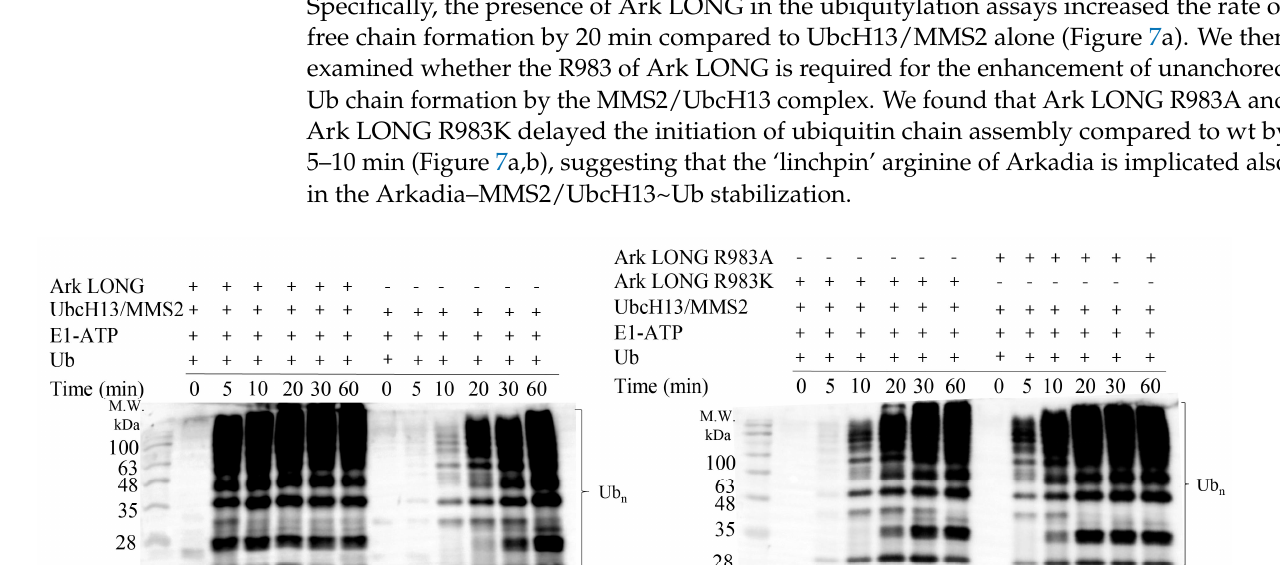
15 of 23 Figure 6. Interaction of E3 Arkadia with UbcH13 E2 enzyme. ( a ) Diagram of the total CSPs measured at a 1:2 molar ratio (saturation point) for 15 N Ark RING/ 14 N UbcH13, *: represents disappeared res- idues, +: represents residues with no information. ( b ) Ark RING mapping (PDBid: 2KIZ) after the addition of UbcH13 (residues that disappeared during the interaction are colored red, whereas res- idues that exhibited ‘fast exchange’ interaction are colored coral). ( c ) Diagram of the total CSPs measured at a 1:2 molar ratio for 15 N UbcH13/ 14 N Ark RING. ( d ) UbcH13 mapping (PDBid: 1J7D) after the addition of Ark RING. ( e ) Diagram of the total CSPs measured at a 1:2 molar ratio for 15 N UbcH13/ 14 N Ark LONG. ( f ) UbcH13 mapping (PDBid: 1J7D) after the addition of Ark RING. ( g ) ITC data for the titration of UbcH13 into Ark RING and ( h ) into Ark LONG. ( i ) In vitro auto-ubiquityla- tion assays using UbcH13 in the presence and absence of Ark LONG ( left ) and in the presence of GST-Ark LONG or GST-Ark RING ( right ). We also tested the cooperation of UbcH13 with Ark RING and Ark LONG in auto- ubiquitylation assays, and we found that UbcH13–Ark LONG synergistic action resulted in the monoubiquitylation of Ark LONG, whereas Ark RING was not capable of perform- ing monoubiquitylation in the presence of UbcH13 (Figure 6i). To separate the monoubiq- uitylated band from the UbcH13-Ub band, we repeated the assay using GST-tagged Ark LONG and Ark RING polypeptides in ubiquitylation with UbcH13. A single band with the anticipated molecular weight (~49 kDa) for the complex GST-Ark LONG-Ub was pre- sent on the Western blot (red box in Figure 6i), confirming the ability of UbcH13 to func-